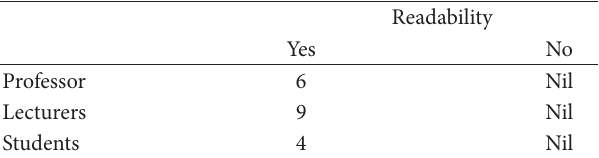
Table 6: Evaluating the comprehensibility of summary generated by system.